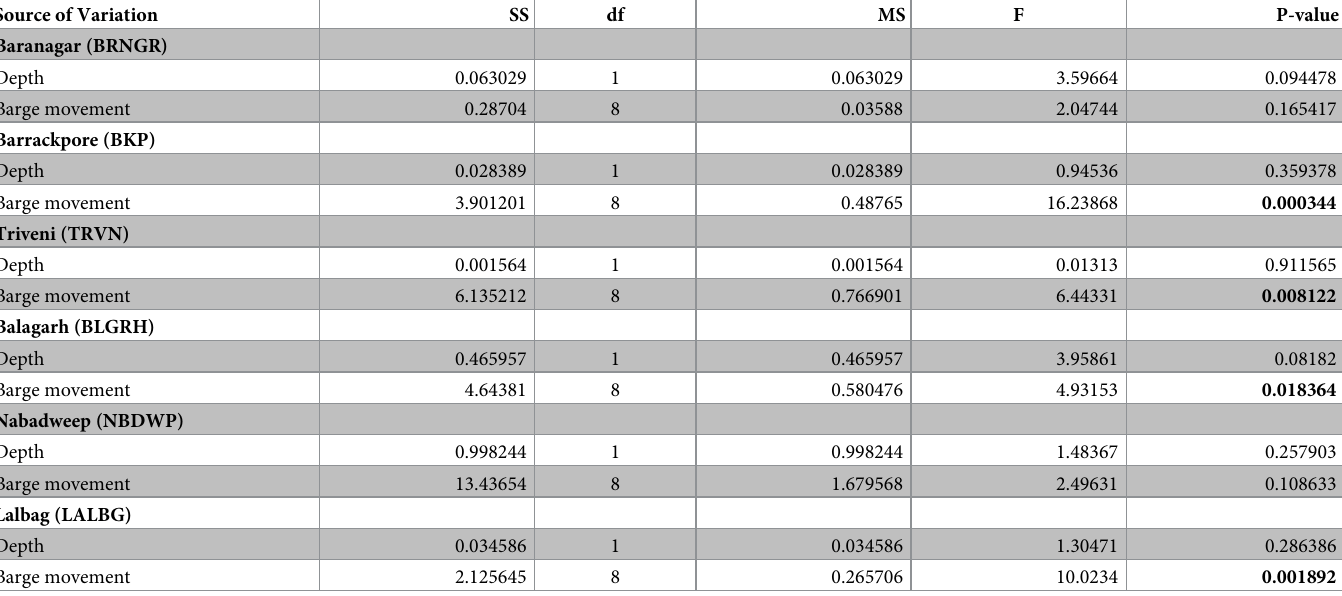
Table 5. ANOVA table depicting impact of barge movement and depth on phytoplankton biomass (Chl a ) at various stations. Source of Variation SS df MS F